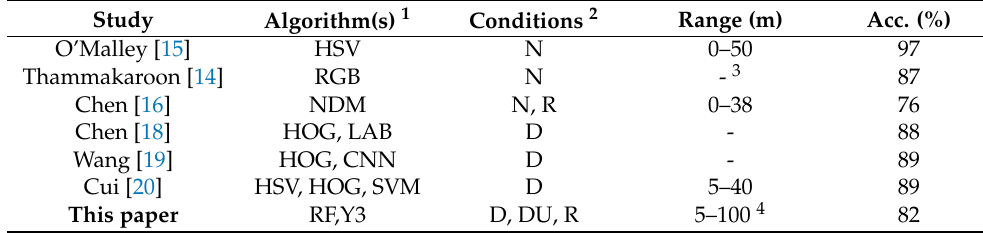
Figure 7. Normalized confusion matrices from the random forest algorithm. Table 6. Comparison of the brake light detection